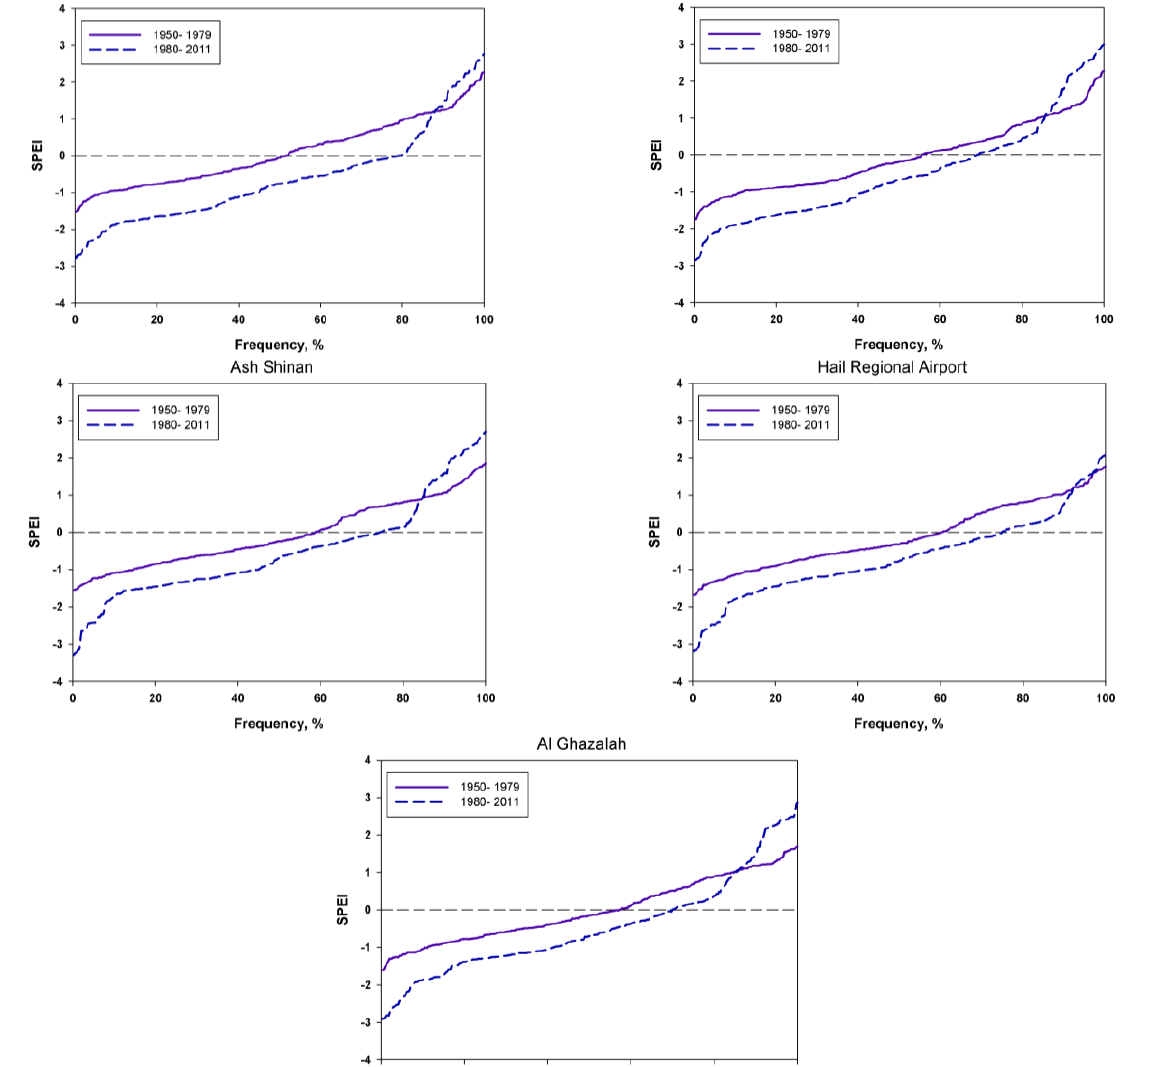
Figure 3. Drought cumulative percent of the Standardized Precipitation Evapotranspiration Index (SPEI) series over a 24-month time scale for different locations within the central area of Saudi